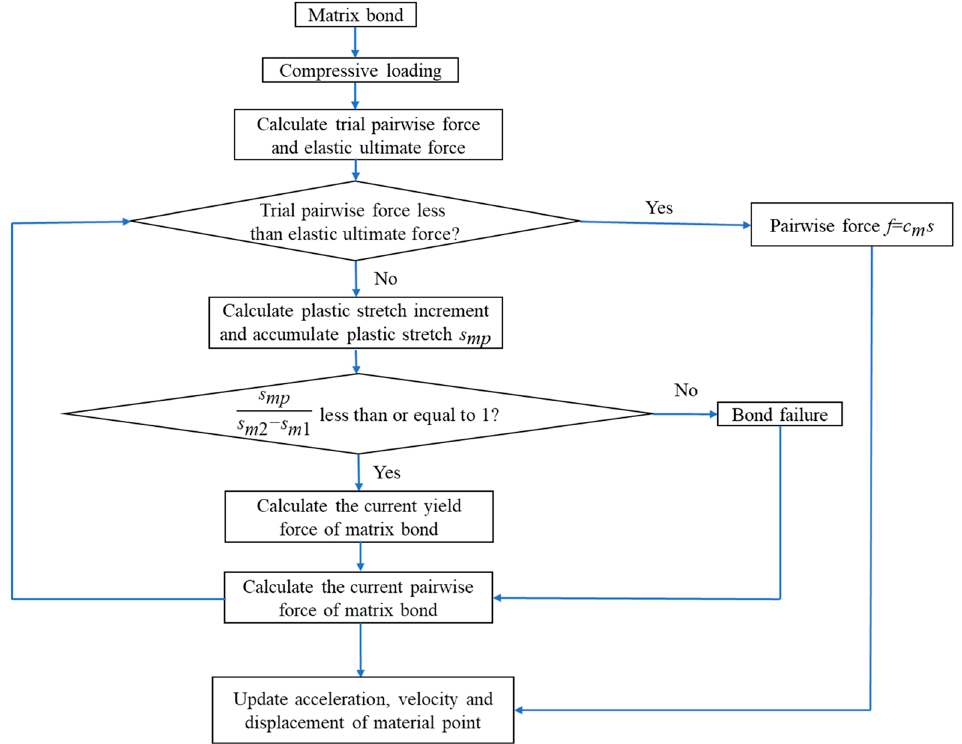
Figure 8. Flowchart of the pairwise force updating algorithm.